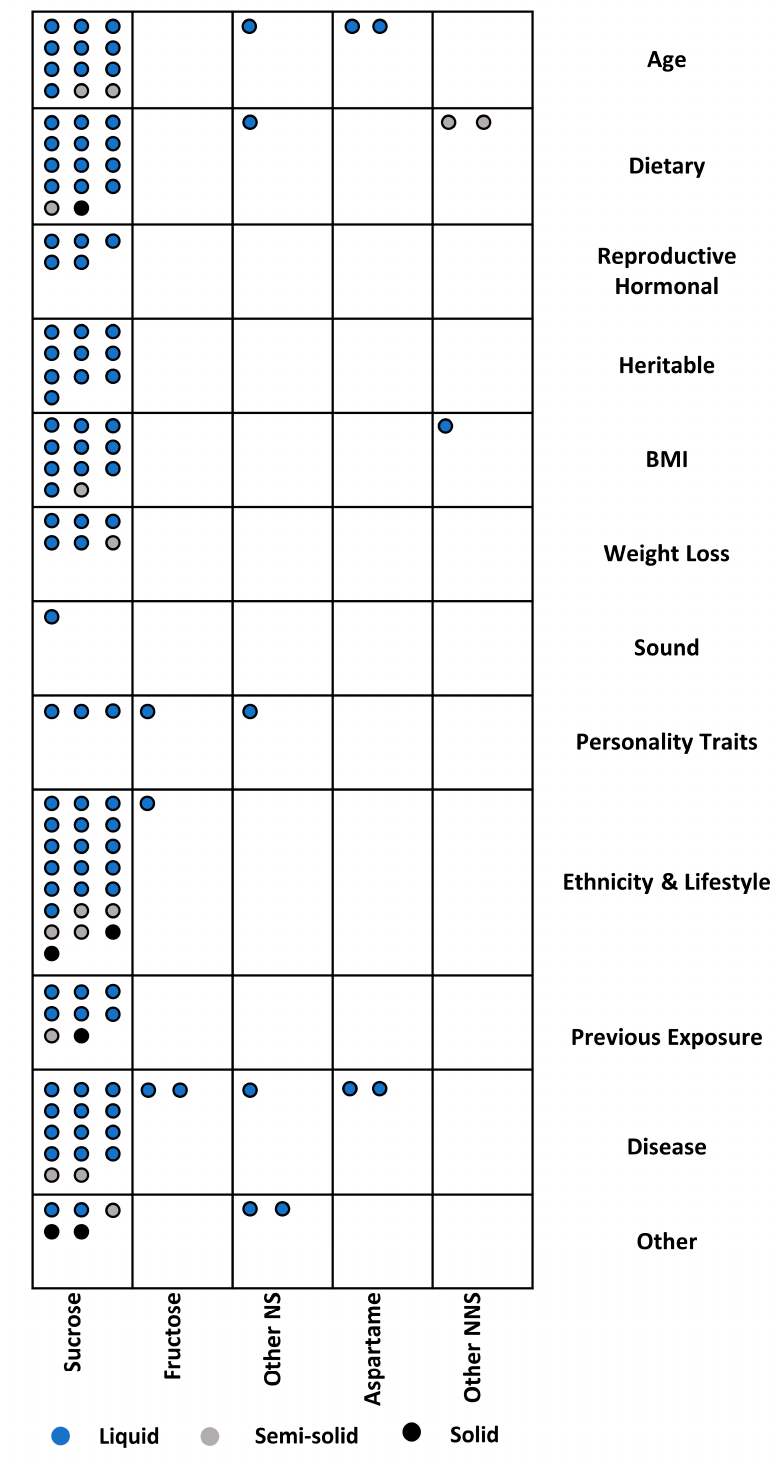
Figure 3. Sweeteners and physical states of sweetness delivery vehicles in sweetness reference studies. Each circle represents a di ff erent food / beverage set within the 98 studies evaluated, where a “set” is defined as one or more variations of the same food or beverage, tested in the same study population, sweetened with the same sweetener (i.e., NS or NNS), but di ff ering only in the level of sweetness. There are a total of 128 food / beverage sets. In several studies, assessments of sweetness preference were completed for multiple “sets”. NS = nutritive sweetener; NNS = non-nutritive